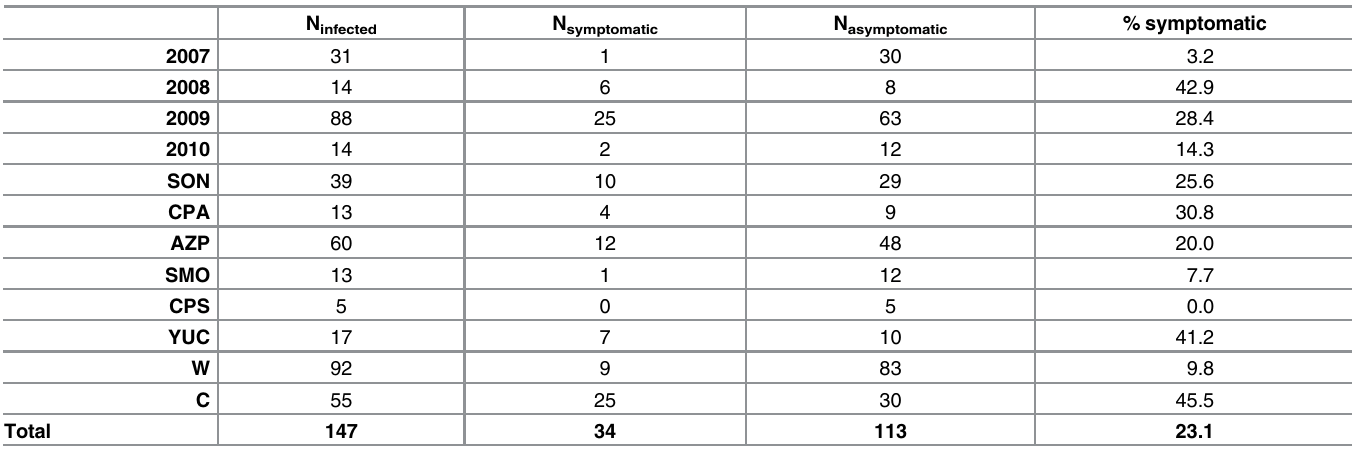
Table 5. Frequency of disease symptoms in infected plants according to year of sampling, geographical province and habitat. N infected N symptomatic N